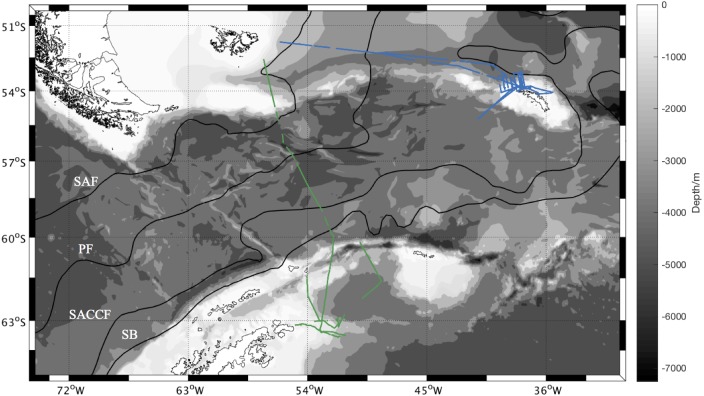
Overview of sampling area.Sampling area with bathymetry from the General Bathymetric Chart of the Oceans (GEBCO) one minute grid (Jakobsson et al., 2008). Isobaths every 1,000 m between 8,000 m and 1,000 m depth, every 200 m between 1,000 m and 0 m. N2O measurement positions during JR260B in blue, N2O measurement positions during JR255A/GENTOO in green. Climatological locations of fronts in black given in Orsi, Whitworth & Nowlin (1995): SAF Sub-Antarctic Front, PF Polar Front, SACCF Southern Antarctic Circumpolar Current Front, SB Southern Boundary of the Antarctic Circumpolar Current.